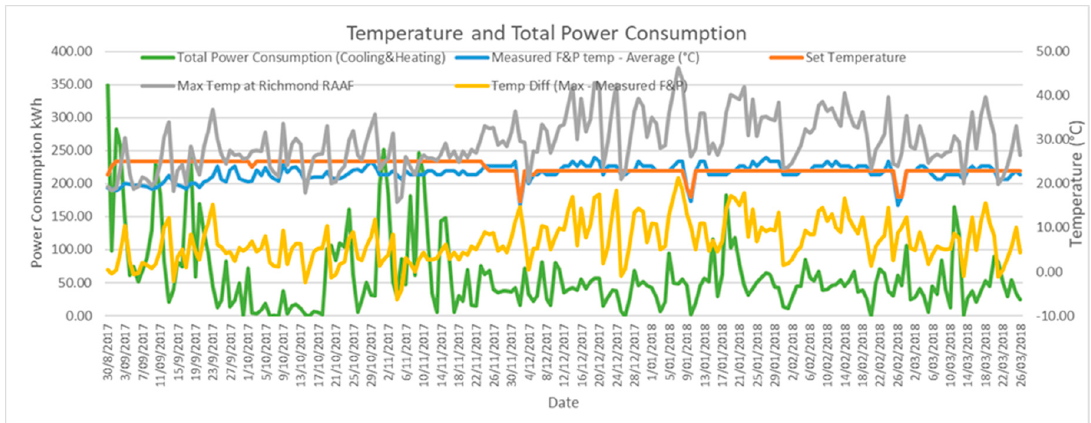
Figure 3. Temperature and power consumption over the full capsicum crop lifecycle.